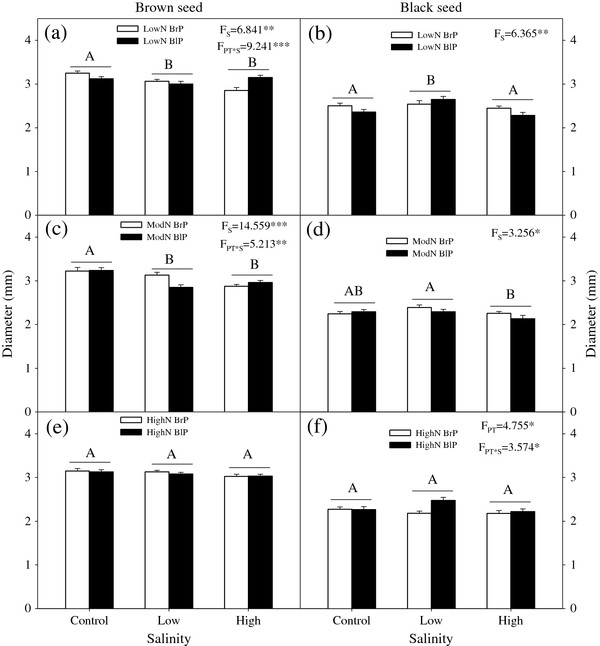
Effects of plant type and salinity on diameter of brown and black seeds for different nutrient availabilities. (a, b) Low nutrient, (c, d) Moderate nutrient, (e, f) High nutrient. N: Nutrient; BrP: Plant grown from brown seed; BlP: Plant grown from black seed. F-values are given when significance levels are reached (S: salinity; PT: plant type; * P < 0.05, ** P < 0.01, *** P < 0.001). Bars with the same uppercase letters are not significantly different at P < 0.05 according to the Tukey’s test.